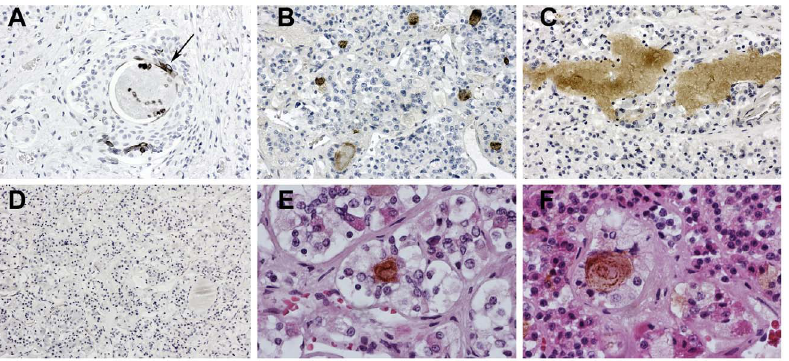
Figure 6. Cthrc1 localizes to the pituitary gland. Immunolocalization of Cthrc1 in human pituitary glands identifies cells expressing Cthrc1 in the anterior lobe (A, arrow). (B, C) Accumulations of colloid-like material contain Cthrc1 immunoreactivity. (D) Absence of non-specific staining is observed with an irrelevant monoclonal antibody. (E, F) Cells surrounding Cthrc1 immunoreactivity are of the chromophobe type. Cthrc1 immunoreactivity in brown with hematoxylin counterstain. Original magnification 200x (A-C), 100x (D), 400x (E,